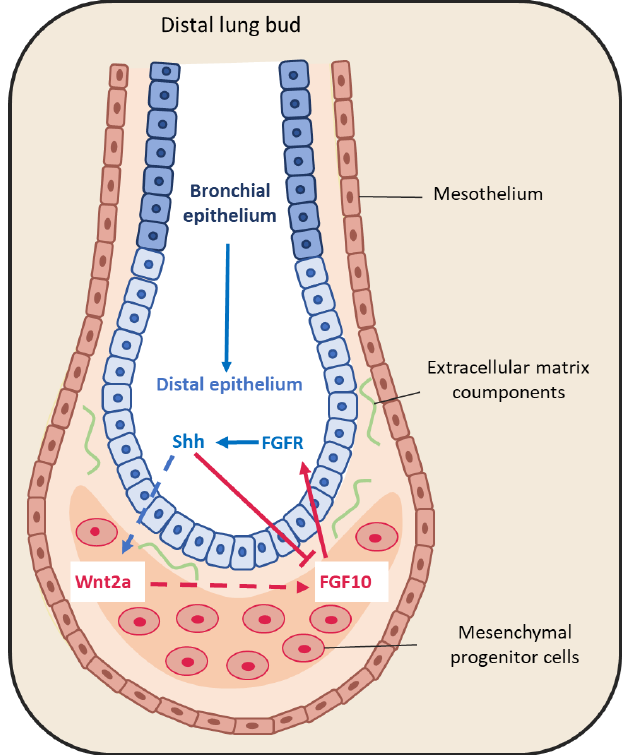
Figure 3. Representative schema of epithelium-mesenchyme interactions during lung budding. Many factors are secreted and exchanged between the lung epithelium (blue arrows) and mesenchyme (red arrows). For instance, fibroblast growth factor 10 (FGF10) is locally expressed by distal submesothelial mesenchymal cells and interacts with its receptor expressed in the distal epithelium. Sonic hedgehog (SHH) is expressed by epithelial cells, and downregulates FGF10 expression through its receptor Patched 1, but also activates FGF10 through the Wnt pathway.